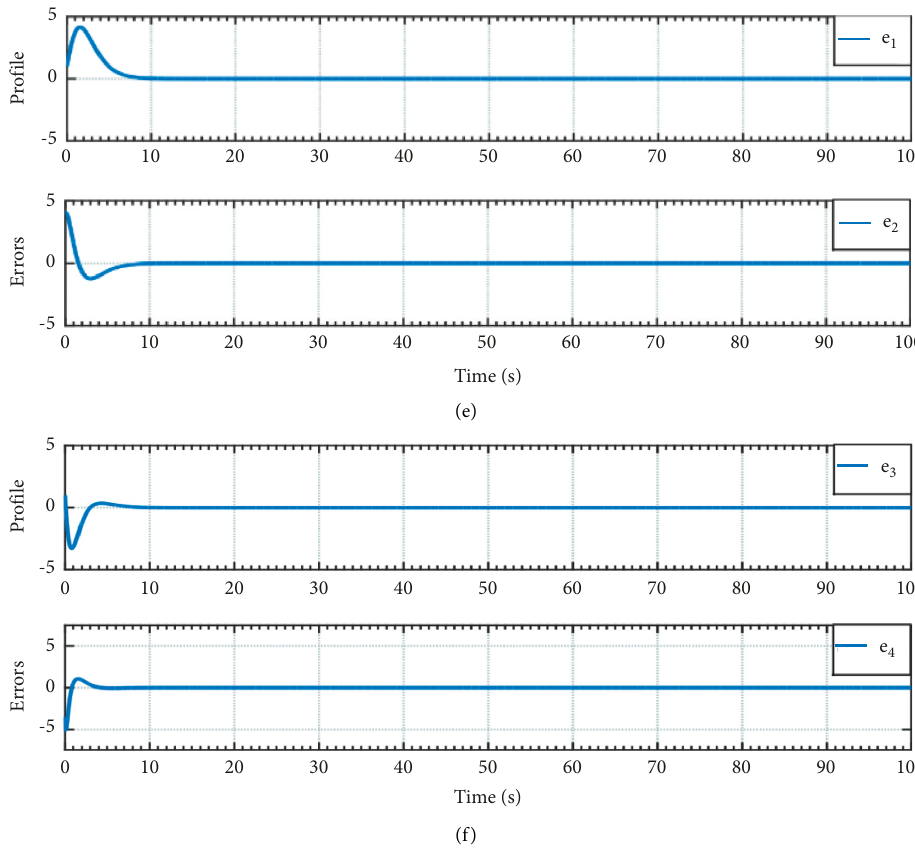
Figure 8: Antisynchronization of identical 4D hyperchaotic financial system. (a) Antisynchronization of interest rate corresponding to ( 0 ) , y ( 0 ) � ( 3 , − 2 )] . (b) Antisynchronization of investment demand corresponding to the initial condition initial condition [ x 1 1 [ x ( 0 ) , y ( 0 ) � ( 1 , 3 )] . (c) Antisynchronization of price index corresponding to initial condition [ x 2 2 synchronization of average profit margins corresponding to the initial condition [ x , e ,e , and e errors e 1 2 3 4